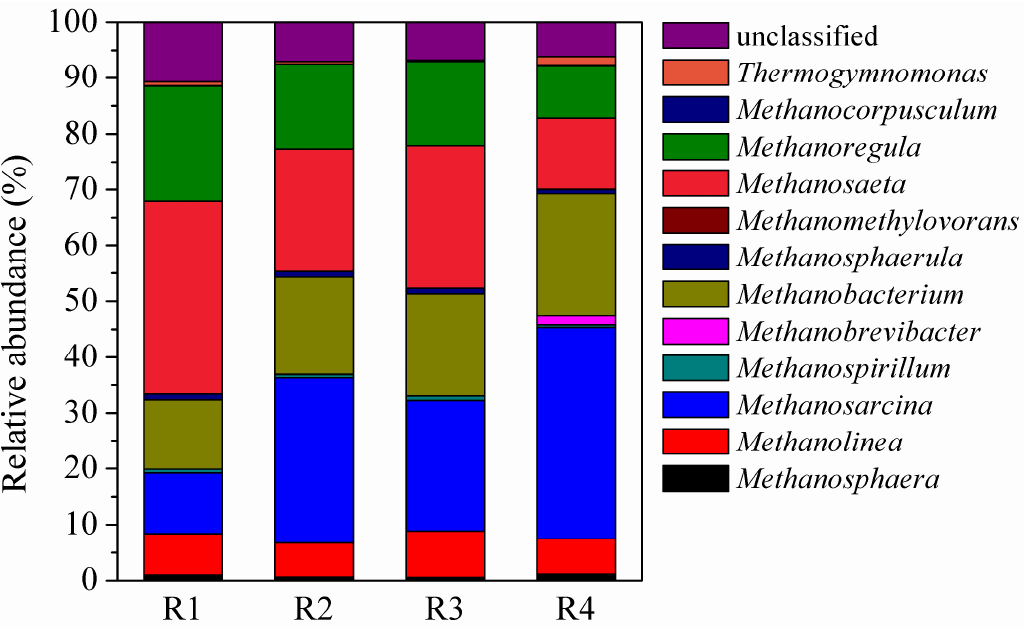
Figure 4. Changes of methanogenic community structure dynamics (at genus level) in R1–R4 reactors.